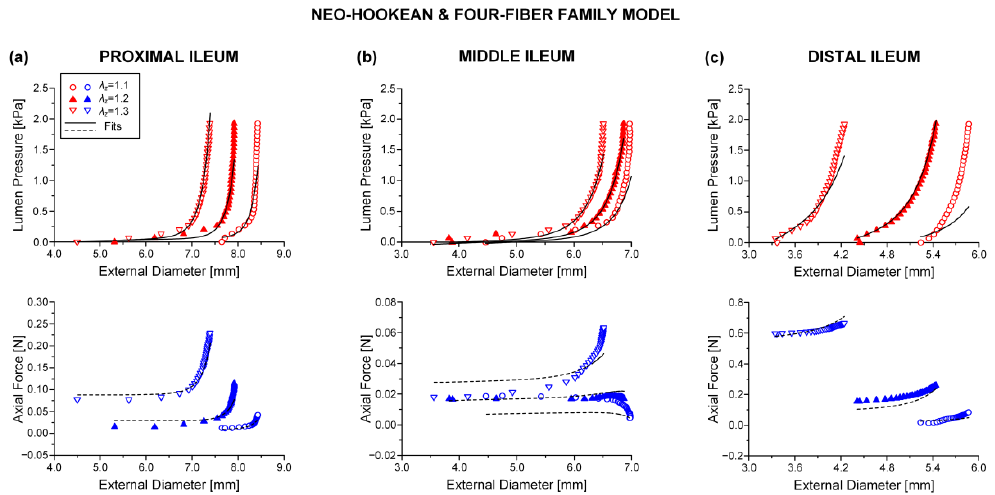
Figure 4. Plot of measured lumen pressure (red color) and axial force (blue color) vs. external diameter data at three different fixed axial stretches 𝜆 𝑧 = {1.1, 1.2, 1.3} for a characteristic specimen from the proximal, middle, and distal ileum and fits (solid lines for lumen pressure and dashed lines for axial force) calculated using the neo-Hookean and four-fiber family microstructure-based model of Equation (1) with the following best-fit model parameters for the ( a ) proximal ileum: 𝜇 = 0.103 kPa, 𝑘 1𝑑 = 0.006 kPa, 𝑘 2𝑑 = 6.312, 𝑘 1𝑎 = 1.966 kPa, 𝑘 2𝑎 = 2.102, 𝑘 1𝑐 = 2.4 × 10 −10 kPa, 𝑘 2𝑐 = 0.008, 𝑎 0 = 0.513 rad, ε = 0.260, 𝑅 2 = 0.905, 𝑑𝑒𝑡 ( 𝐑 ) = 3.5 × 10 −6 , ( b ) middle ileum: 𝜇 = 3.2 × 10 −11 kPa, 𝑘 1 𝑑 = 0.694 kPa, 𝑘 2 𝑑 = 4.890, 𝑘 1 𝑎 = 3.722 kPa, 𝑘 2𝑎 = 7.2 × 10 −11 , 𝑘 1𝑐 = 4.0 × 10 −11 kPa, 𝑘 2𝑐 = 1.548, 𝑎 0 = 0.852 rad, ε = 0.380, 𝑅 2 = 0.788, 𝑑𝑒𝑡(𝐑) = 9.2×10 −6 , and ( c ) distal ileum: 𝜇 = 7.0 × 10 −14 kPa, 𝑘 1𝑑 = 3.629 kPa, 𝑘 2𝑑 = 24.221, 𝑘 1𝑎 = 6.730 kPa, 𝑘 2𝑎 = 4.560, 𝑘 1𝑐 = 0.724 kPa, 𝑘 2𝑐 = 1.023, 𝑎 0 = 0.626 rad, ε = 0.333, 𝑅 2 = 0.864, 𝑑𝑒𝑡(𝐑) = 5.3 × 10 −5 . Data are shown every 0.5 mmHg for clarity.